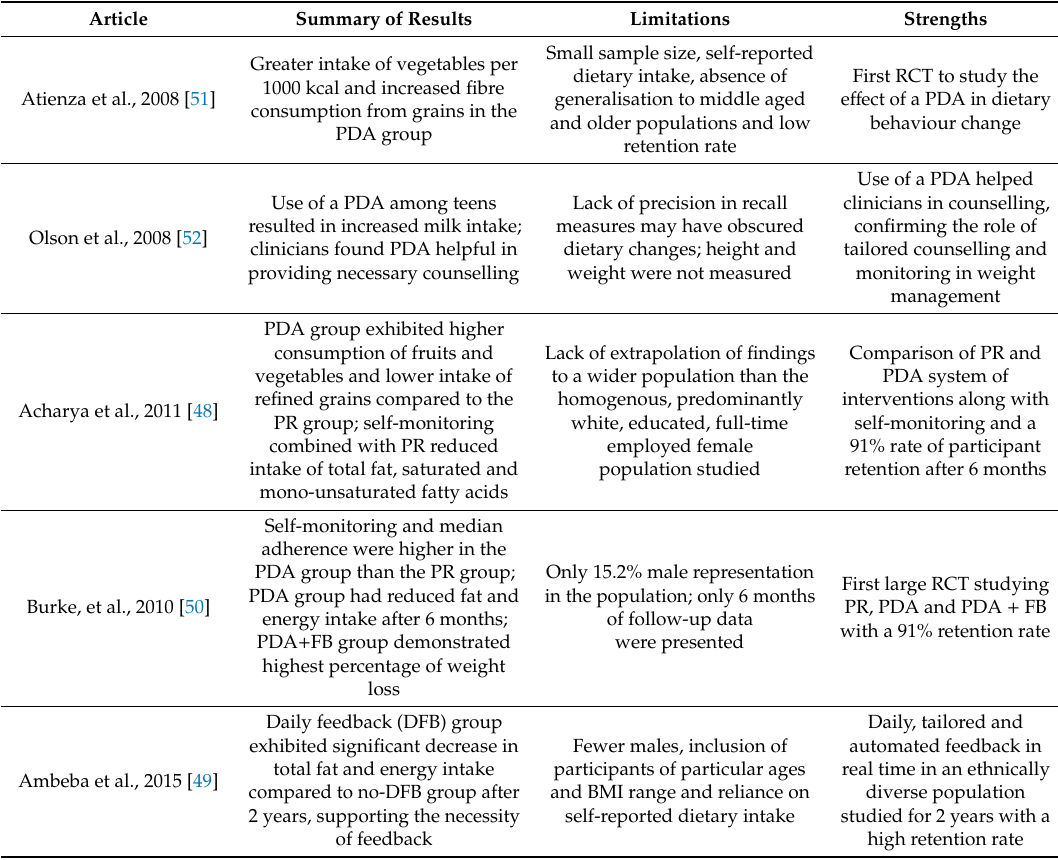
Table 2. Summary of results from studies using a Personal Digital Assistant (PDA) as a digital intervention for dietary behavior